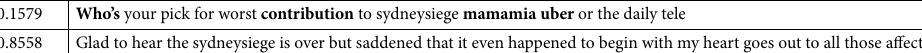
Table 3. Examples of D explain and D classify ’s prediction on rumor (first) and non-rumor (second). The suspicious words in the rumor predicted by D explain are marked in bold. D classify provides a score ranging from 0 to 1. 0 and 1 represent rumor and non-rumor, respectively.